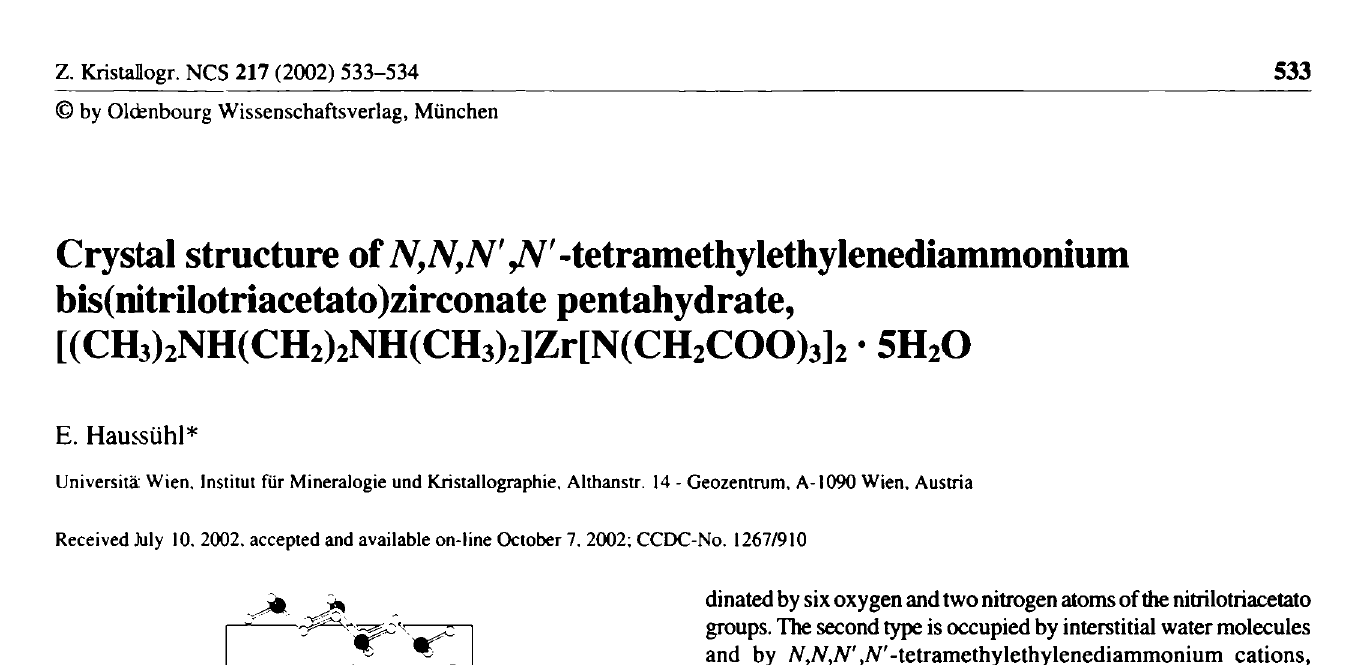
Table 1. Data collection and handling.